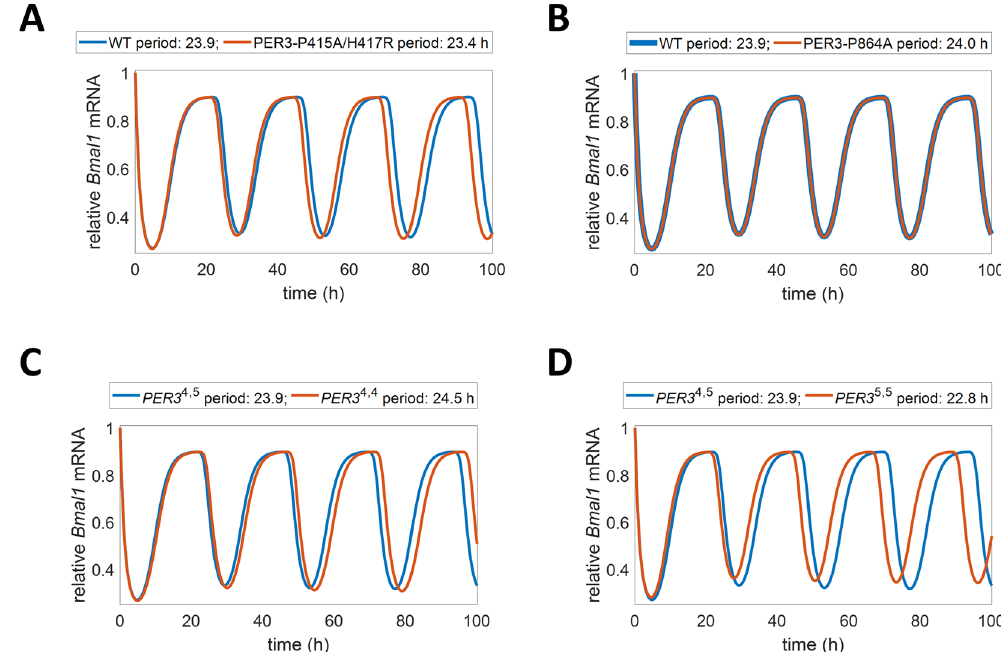
Figure 4. Time series data reflecting SNP/VNTR conditions for a representative individual. ( A ) The model accurately reflects predicted phenotypes for individuals with PER3-P415A/H417R mutations, displaying a shorter period for nuclear BMAL1 mRNA after an 80% reduction in PER1-PER3 binding rate and an 8-fold increase in PER3 degradation rate ( p < 0.001 ) 30 . (See Tables S2, S5, and S6 for more information about variants). ( B ) The model accurately reflects predicted phenotypes for individuals with PER3-P864A missense mutations, displaying a lengthened period for a representative individual after an 80% decrease in PER3- CKI binding ( p < 0.001 ) 11 . ( C ) The model accurately represents individuals representative of homozygotes of PER3 4,4 after a 40% decrease in PER3 phosphorylation rate 25 . The PER3 4,4 homozygous individual displays a lengthened BMAL1 mRNA period relative to a heterozygous individual ( p < 0.001 ). ( D ) The model accurately represents individuals representative of homozygotes of PER3 5,5 25 . The PER3 5,5 homozygous individual displays a shortened BMAL1 mRNA period relative to a heterozygous individual after a 4-fold increase in PER3 phosphorylation rate ( p < 0.001 ) 25